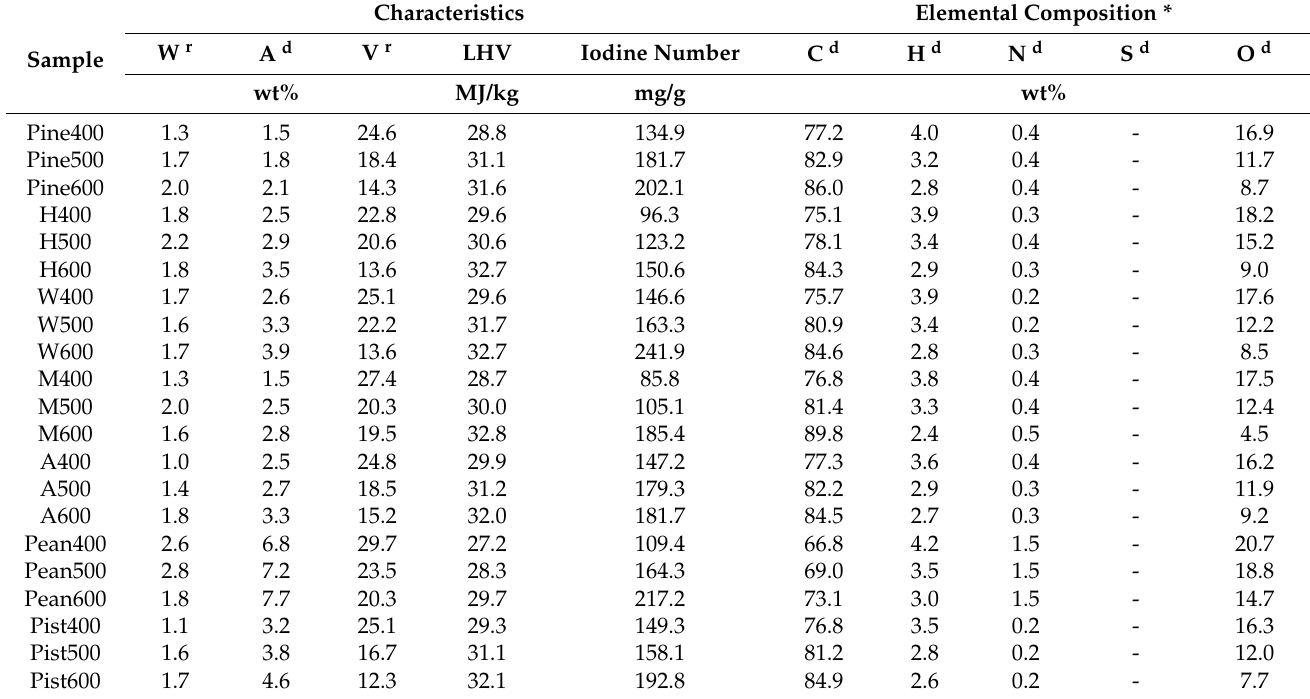
Table 3. Physicochemical characteristics of the biochar